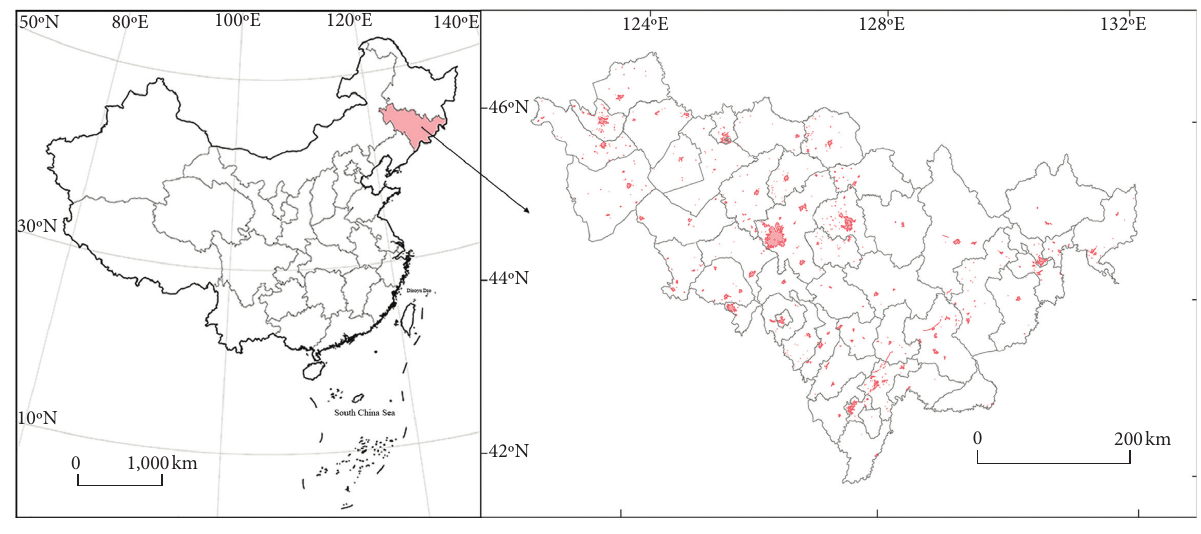
Figure 1: Location of the study area (Jilin,